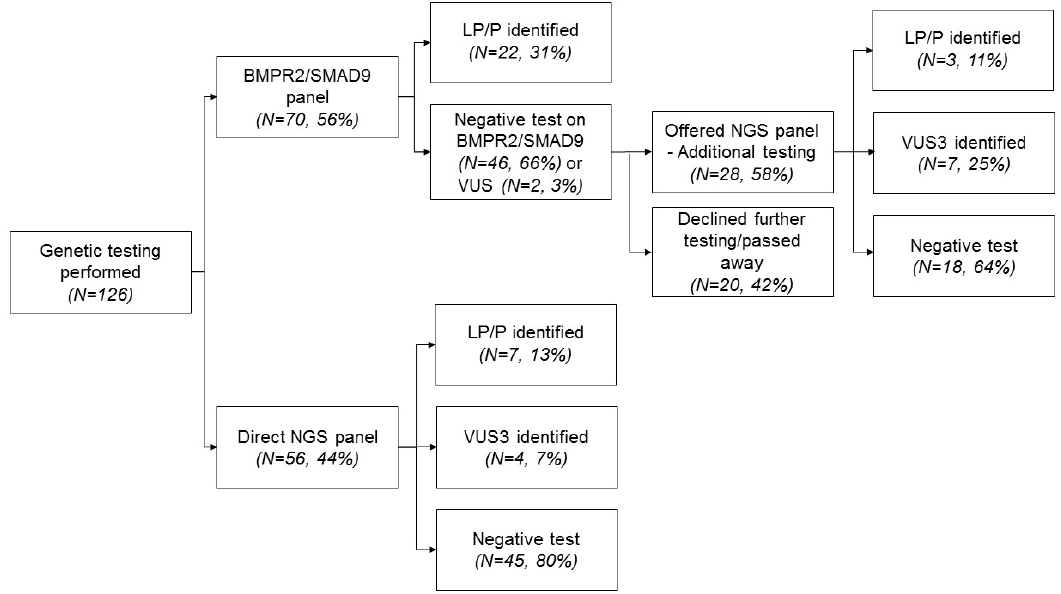
Figure 1. Flow-chart of genetic analyses in idiopathic/pulmonary veno occlusive disease (IPAH/PVOD) patients.